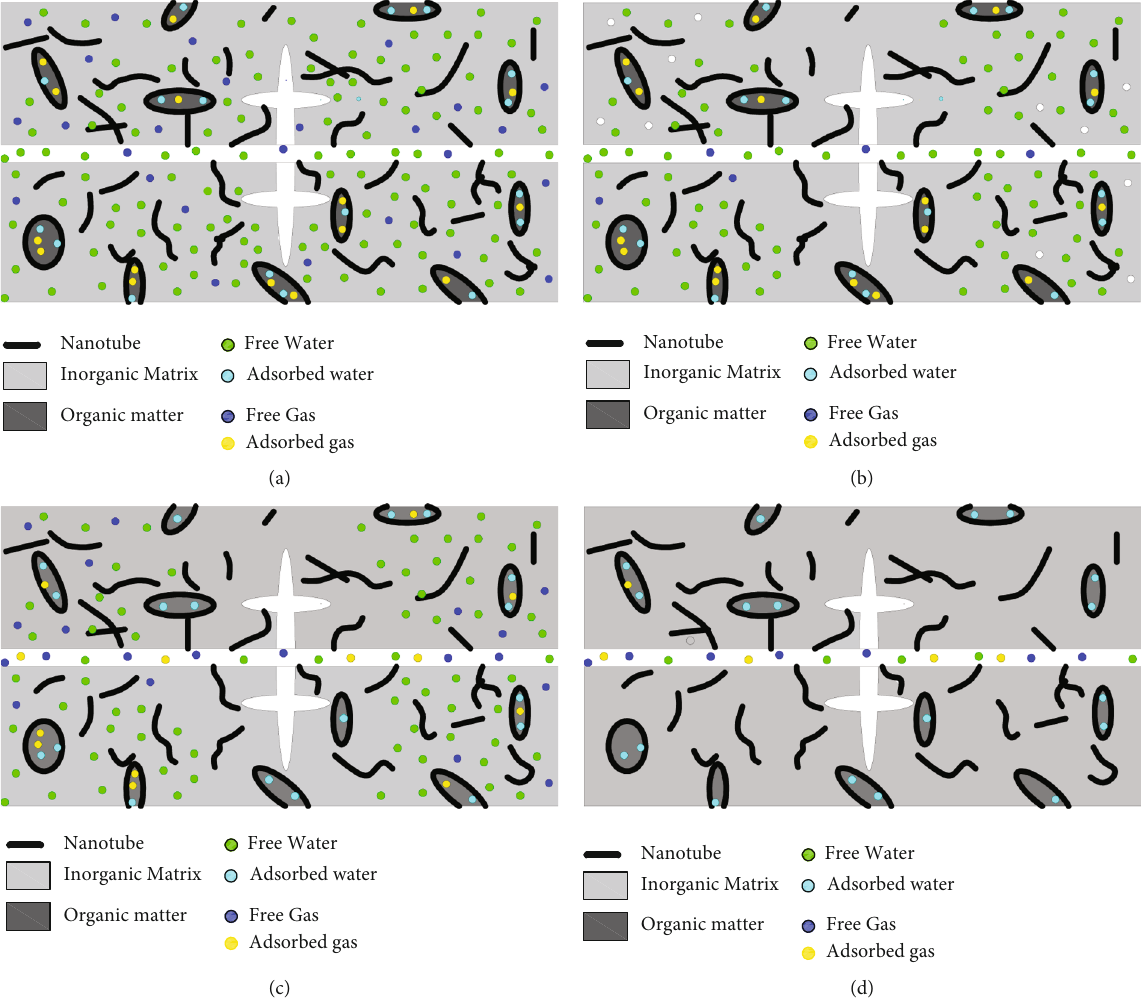
Figure 3: Schematic illustration of the gas production process: (a) bubble fl ow, (b) water-dominant two-phase fl ow, (c) gas-dominant two-phase fl ow, and (d) the new equilibrium